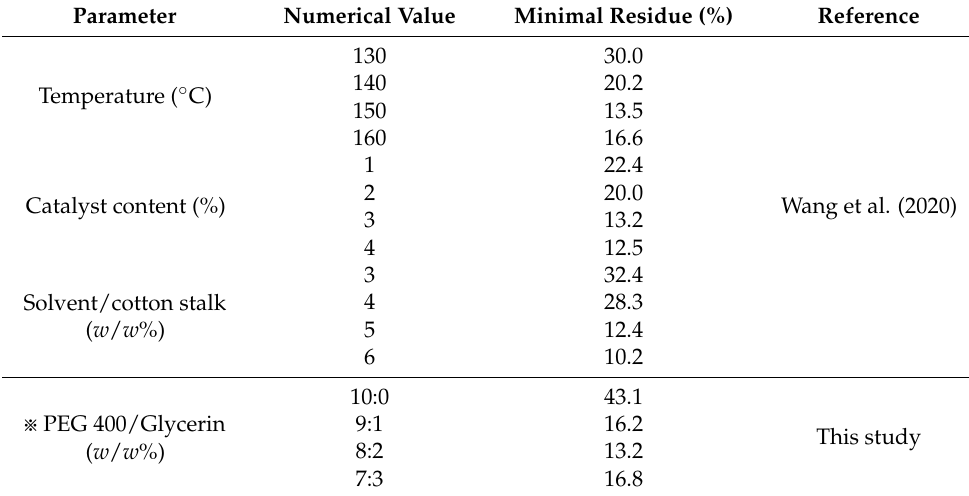
Table 1. Effect of reaction conditions on the minimal